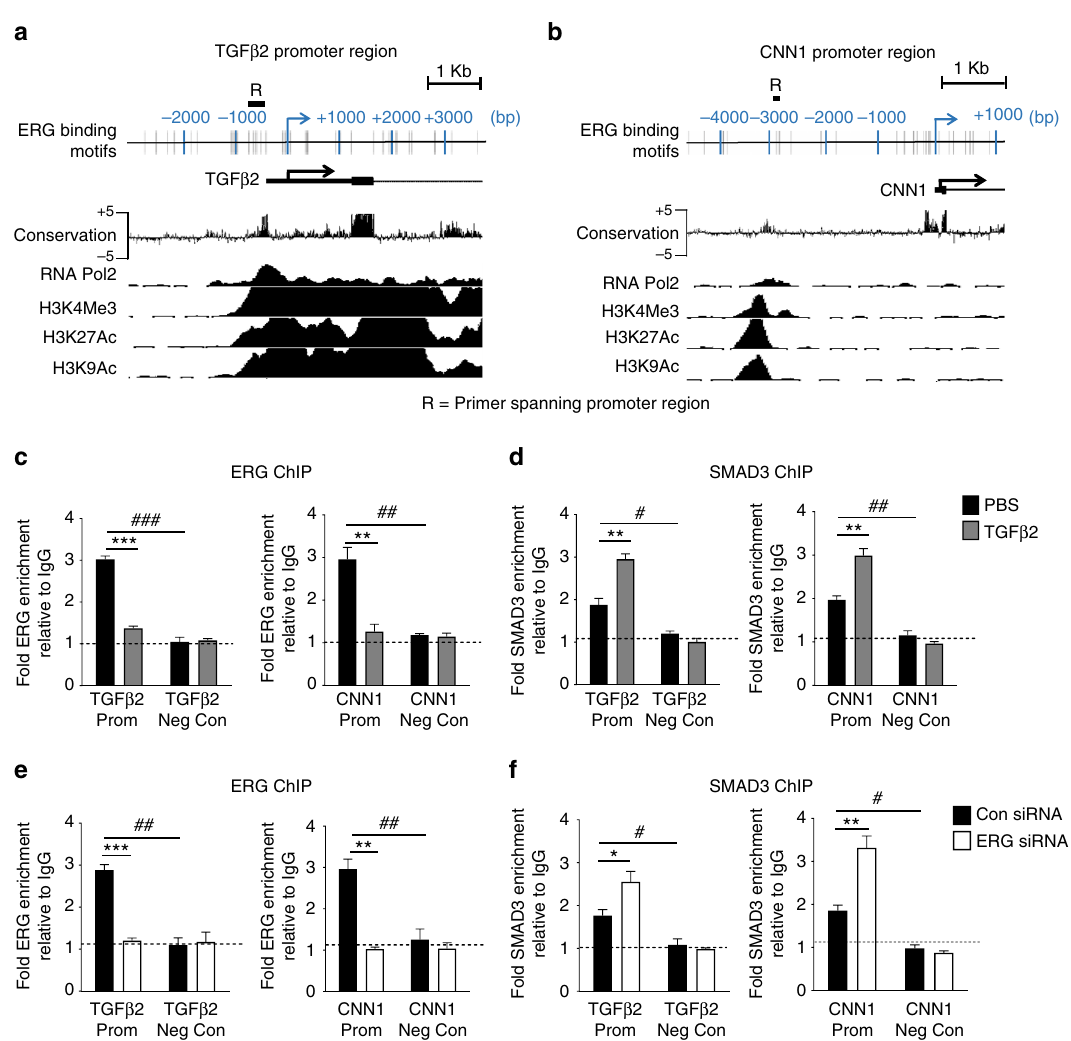
Fig. 3 ERG is a key factor for endothelial speci fi c inhibition of SMAD3-DNA binding. Putative ERG binding sites (grey bars) are located within the a TG β 2 and b CNN1 promoters upstream of the transcription start site (TSS) (arrow); ENCODE sequence conservation between 100 vertebrates across this region is shown. ENCODE ChIP-seq data pro fi le for H3K4Me3, H3K27Ac, H3K9Ac and RNA polymerase II (RNA Pol2) in HUVEC indicate open chromatin and active transcription. Location of qPCR amplicon region R is indicated. ChIP-qPCR analysis of HUVEC was assessed following treatment with c and d TGF β 2 or PBS for 30 min, or e and f control or ERG siRNA. Chromatin was immunoprecipitated with c and e an α -ERG antibody, d and f α -SMAD3 antibody or control IgG. DNA was analysed by qPCR comparing speci fi c primers against a negative control region for each target. Results are expressed as fold change compared to IgG ( n = 3 for all experiments). Basal enrichment was analysed compared to negative control region (#). TGF β 2 or ERG siRNA treatment were compared to PBS treated or control siRNA (*) mean ± s.e.m., * or # P < 0.05, ** or ## P < 0.01, *** or ### P < 0.001 by unpaired t -test pathological differences between ALD, PBC and NASH patients. Therefore, we propose that ERG may represent a sensitive tissue biomarker to monitor vascular dysfunction and in fl uence ther- apeutic strategies. rheumatoid arthritis 44 . Since ERG expression can be down- plays a key role in the loss of ERG expression in these patients. Interestingly, etanercept could restore ERG expression and reduce SMAD3 activity in the in vivo model of CCL 4 -induced liver fi brosis in wild-type mice, but was ineffective in Erg cEC-het mice, suggesting that anti-TNF therapies exert a bene fi cial effect by restoring endothelial homoeostasis through the ERG pathway. In conclusion, our fi ndings identify ERG as a novel EC-speci fi c regulator of canonical TGF β /BMP, promoting EC-dependent tissue homoeostasis. We provide evidence that loss of ERG expression is an early, causative event during liver fi brogenesis.